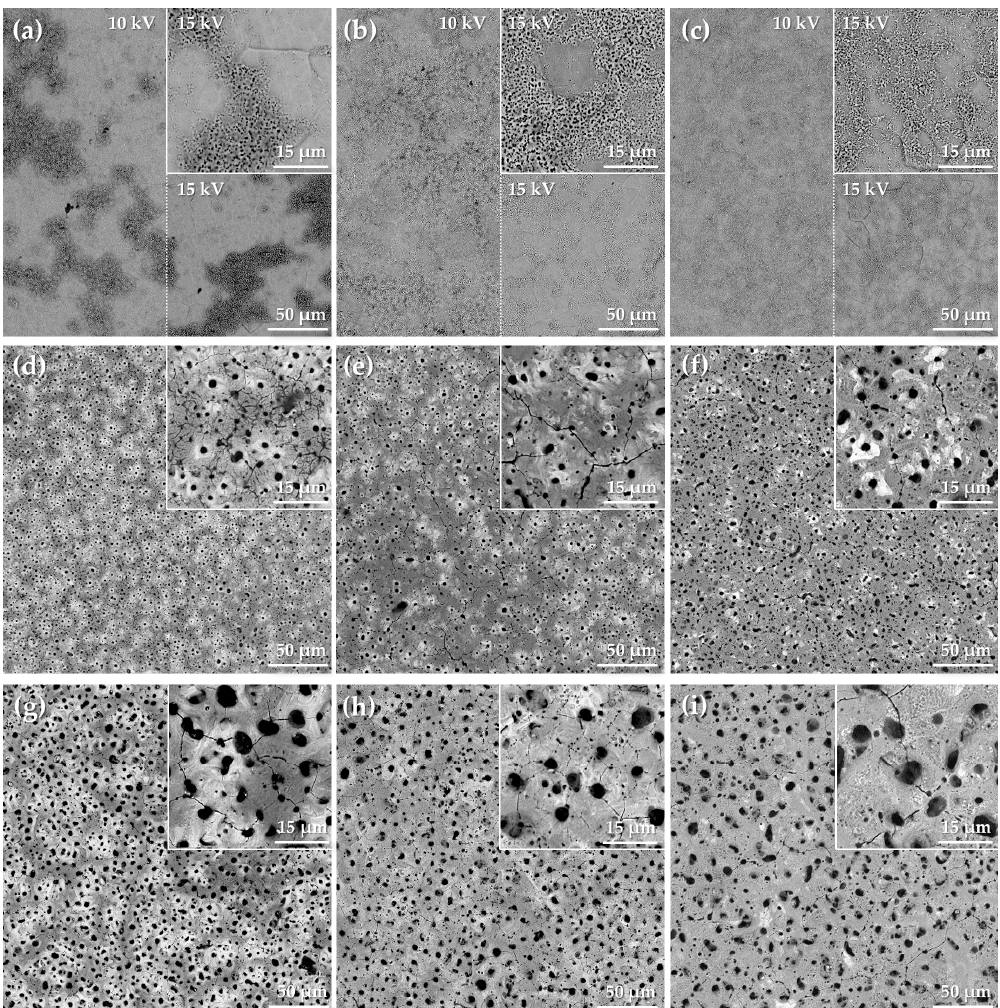
Figure 3. Surface morphologies of the PEO coatings formed on zirconium up to 200 ( a – c ), 300 ( d – f ) and 400 V ( g – i ) in the Ca1P2 ( a , d , i ), Ca2P1 ( b , e , h ), and (CaMg)2P1 ( c , f , i ) solutions. In the case of the samples that were treated up to 200 V half of the image is presented under accelerating voltage of 10 kV, while the other half was taken at 15 kV. The insets correspond to the larger magnifications of the same images.